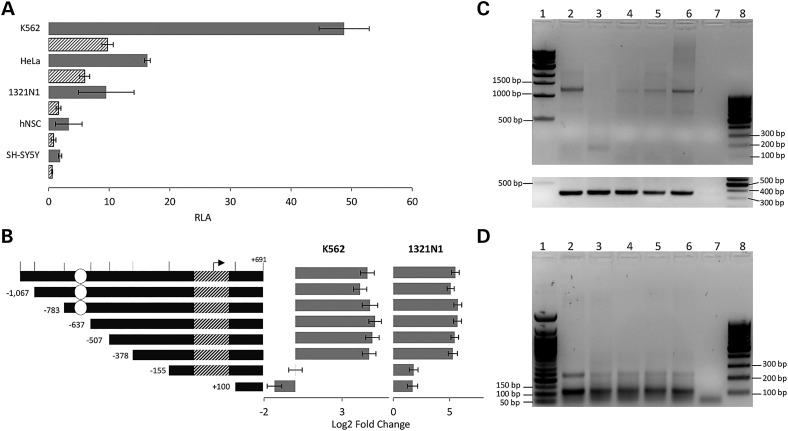
Characterization of the PCSK6 region associated with handedness. (A) The genomic region spanning the regulatory elements at the PCSK6 locus (orange box, Fig. 1B) was cloned into a luciferase reporter vector in both sense and antisense directions. Bars (grey for sense and striped for antisense direction) show mean FC in relative luciferase activity (RLA) following normalization with the Renilla construct and relative to the empty pGL4 vector in five cell lines. Bars indicate mean ± SD (n = 4). (B) Minimal promoter analysis of the sense construct. Luciferase-expressing constructs containing different segments of the region upstream of the TSS of the short-sense PCSK6 isoform were analysed for promoter activity in K562 and 1321N1 cells. The rs11855415 SNP and the VNTR location are indicated by a white circle and a striped bar, respectively. An arrow indicates the position of the TSS of the PCSK6 short-sense isoform. The vertical bars on the top segment indicates the sites targeted by restriction enzymes to generate the different constructs (from left to right: KpnI, Ndei, AwrII, SanDi, StuI, PfIMI, AcII and BsaAI). Luciferase expression was measured relative to the empty pGL4 vector and log-transformed; all assays were performed in triplicate and repeated at least three times. Bars represent mean ± SD (n = 3). (C) Detection of a novel PCSK6 isoform. A PCR fragment of 1247 bp spans a novel exon, immediately adjacent to the regulatory region tested in A) (see also Fig. 1) to the 3′ UTR of the full-length transcript (see Supplementary Material, Fig. S3). cDNA quality was confirmed for all cell lines by targeting the β-actin transcript (353 bp), a house-keeping gene (see Supplementary Material, Fig. S3). (D) A PCR fragment of 112 bp detecting the RNA antisense molecule PCSK6-AS1 with primers targeting the first and second exons. A less intense band of 232 bp corresponds to an alternatively spliced isoform (PCSK6-AS2) (see Supplementary Material, Fig. S3 for details of primer design). Sample order in both (C) and (D): lanes 2–6: K562, HeLa, 1321N1, hNSC and SH-SY5Y; lane 7: negative control; lanes 1 and 8, reference ladders (1 kb and 100 bp in C, and 50 bp and 100 bp in D).